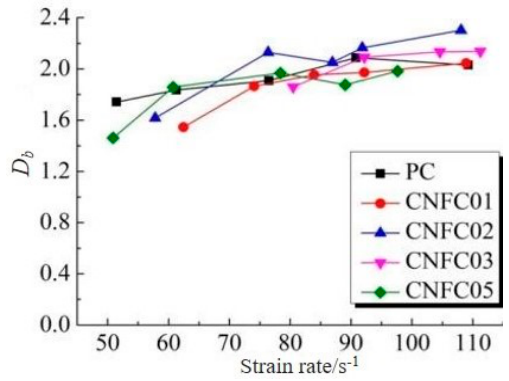
Figure 13. Relationship between D b and strain rate.